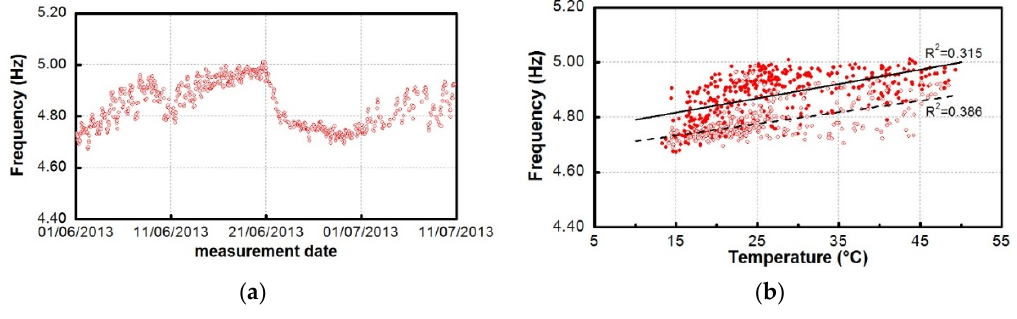
Figure 13. Mode T 1 : ( a ) variation of the natural frequency between 01/06/2013 and 10/07/2013; and ( b ) change in the frequency-temperature correlation induced by the seismic event of 21/06/2013. Appl. Sci. 2016 , 6 , 173